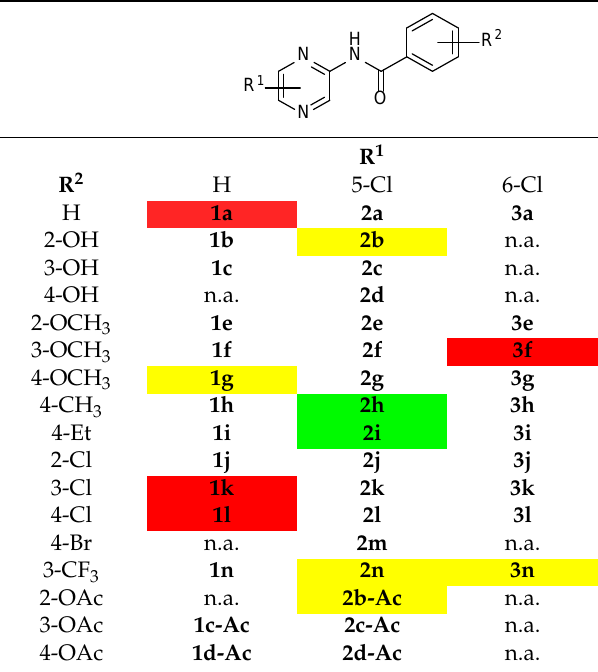
Table 1. Summary of prepared derivatives—code assignment and activity against Mtb. Green—MIC Summary of prepared derivatives—code assignment and activity against Mtb. = 3.13–6.25 µg/mL; Yellow—MIC = 12.5–25 µg/mL; Red—MIC = 50–100 µg/mL; White—MIC > 100 µg/mL (not active); n.a. = compound not available (not